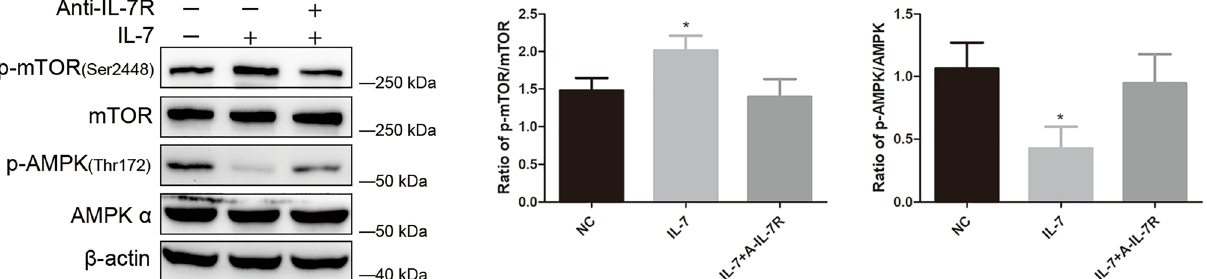
Figure 2. IL-7 regulating AMPK/mTOR pathway. Western blot analysis show down-regulation of phosphorylated (p)-AMPK proteins and up-regulation of p-mTOR protein in A549 cells after treated with IL-7, and using A-IL-7R specific antibody block the effect of IL-7, however the expression level of total AMPK and mTOR are not significantly affected. All the bar graph expressed as Mean ± SD, n = 3. *represent for P < 0.05 versus negative control (NC). **represent for P < 0.01 versus NC.